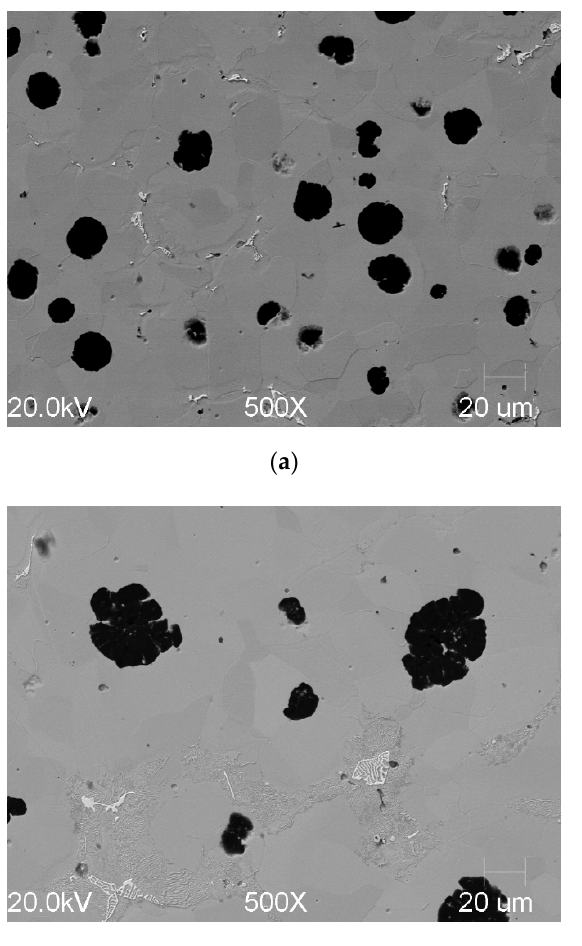
Figure 5. SEM microstructure of Si–Mo ductile iron in castings with different wall thicknesses: ( a ) 3 mm; ( b ) 5 mm; ( c ) 13 mm; and ( d ) 25 mm. Nital-etched samples.